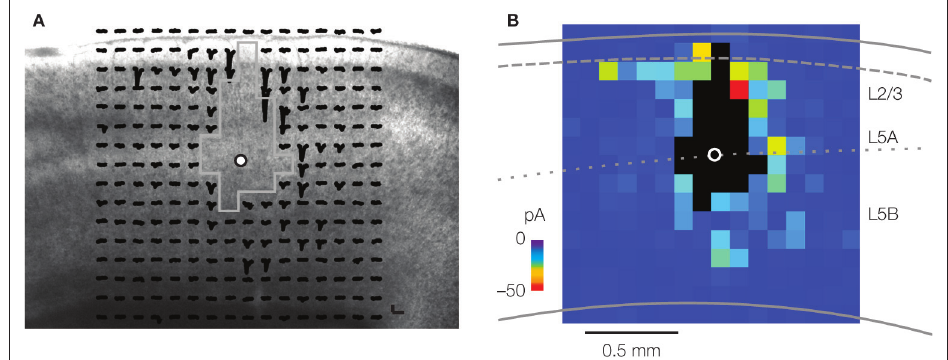
Figure 3 | Synaptic mapping of excitatory inputs to layer 5 pyramidal neurons. (A) Image of slice with array of traces superimposed, showing spatial distribution of presynaptic partners of a pyramidal neuron located at the border of L5A and L5B. Strongest responses were evoked at stimulating sites in L2/3 and L5. (B) Synaptic input map for the same neuron, constructed by averaging the responses to photostimulation across the three map trials. For details, see Yu et al.